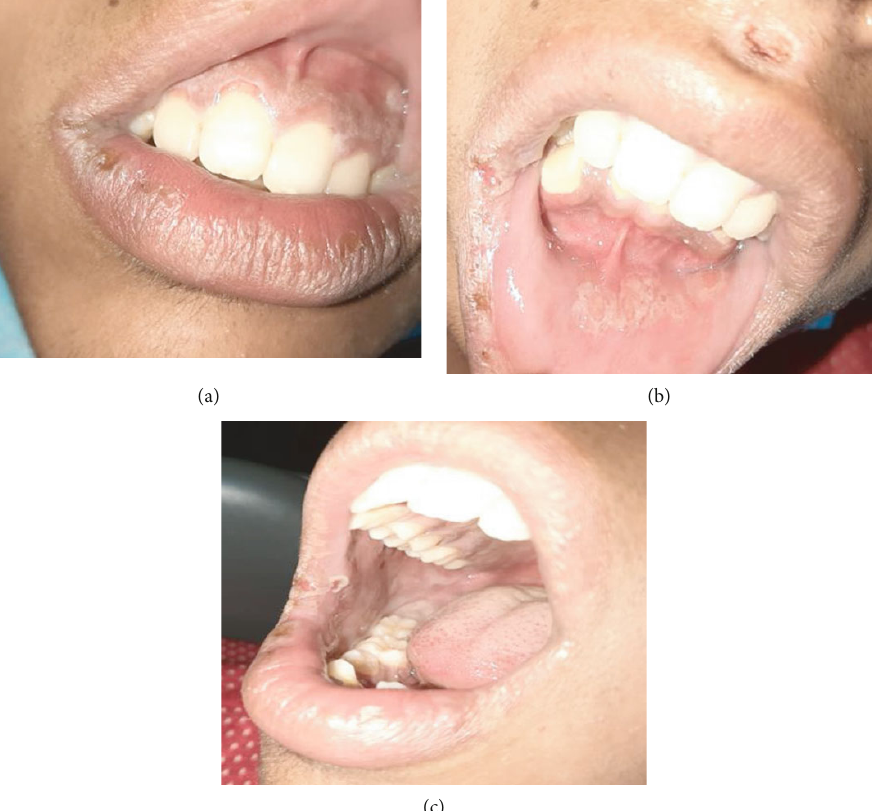
Figure 3: Oral lesions of oral erythema multiforme. The oral lesions involve (a) the gingival, (b) labial, and (c) buccal mucosae and vermilion of the lips.